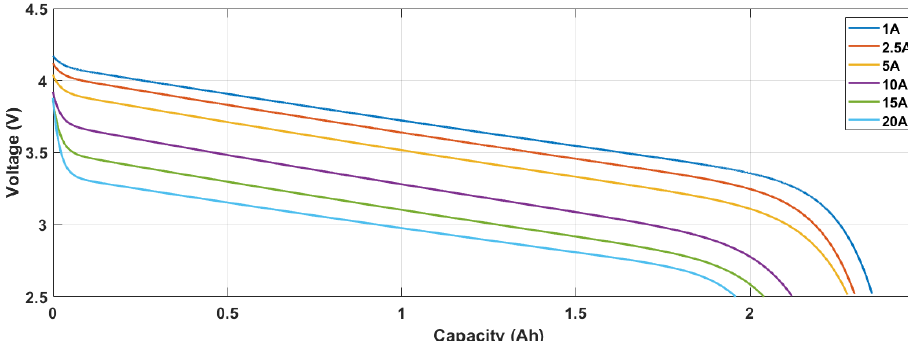
Figure 8. Discharge characteristics for SoH = 94%.